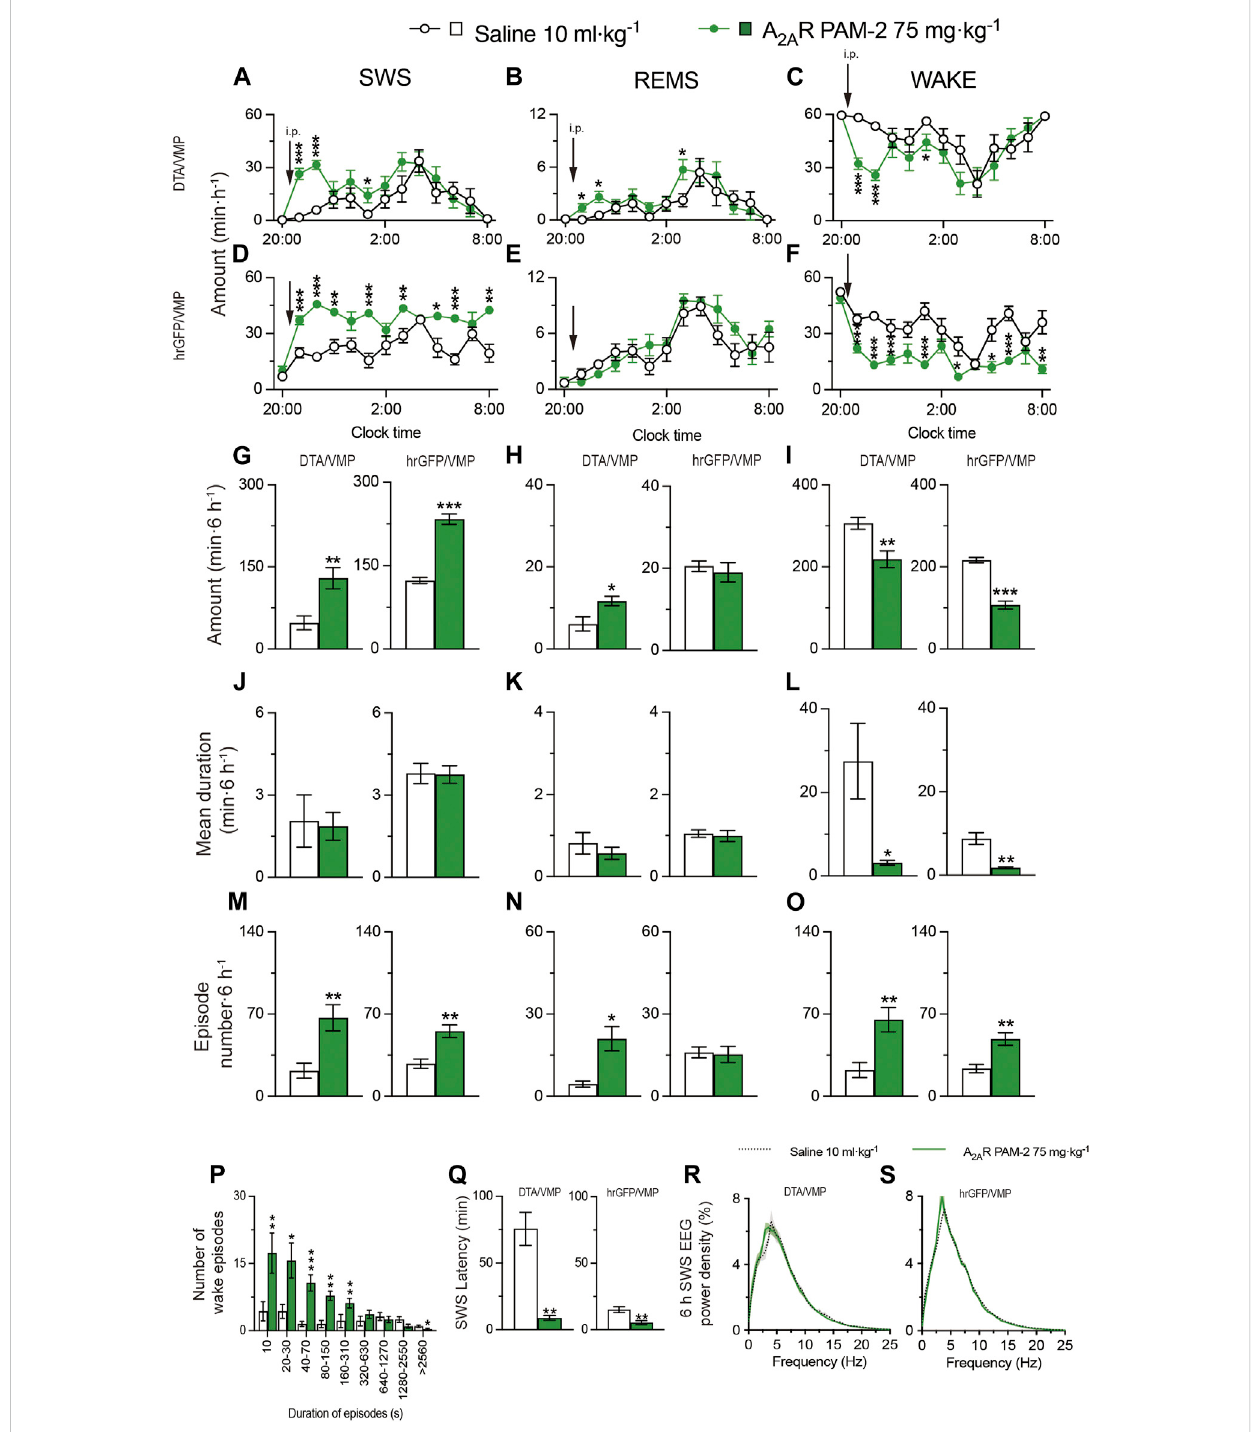
FIGURE 3 IntraperitonealinjectionofA 2A RPAM-2inducessleepinmicewithmania-likebehavior. (A – O) Timecourse (A – F) ,totalamount (G – I) ,meanduration (J – L) , and episode number (M – O) of SWS, REMS, and wakefulness in VGAT-Cre DTA/VMP and VGAT-Cre hrGFP/VMP mice after administering saline or